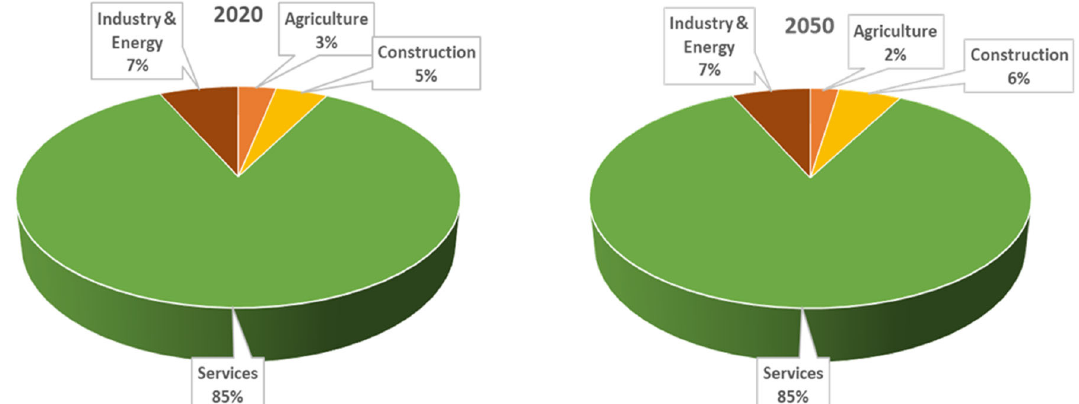
Figure 8. Structure of Mayotte’s economy in 2020 and 2050 [22] .